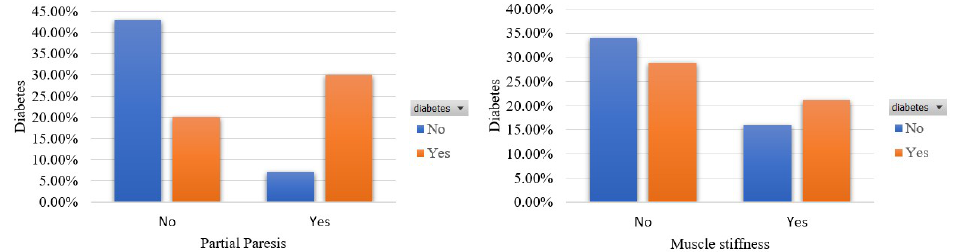
Figure 7. Participants’ distribution in terms of partial paresis and muscle stiffness in the bal- anced dataset.